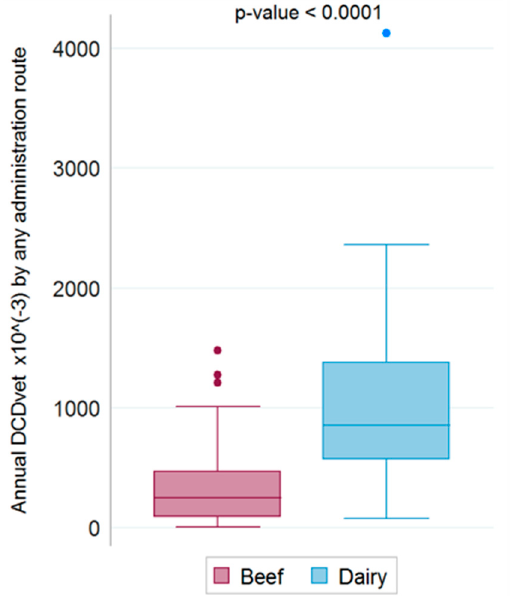
Figure 4. Annual consumption of antibiotics via any administration route on beef and dairy farms. Data on the average consumption via parenteral, oral, and intrauterine administration routes for beef and dairy farms were expressed in defined daily doses (DDD vet )/year and DCD vet /year and are presented per antimicrobial class in Tables 1 – 3, respectively.